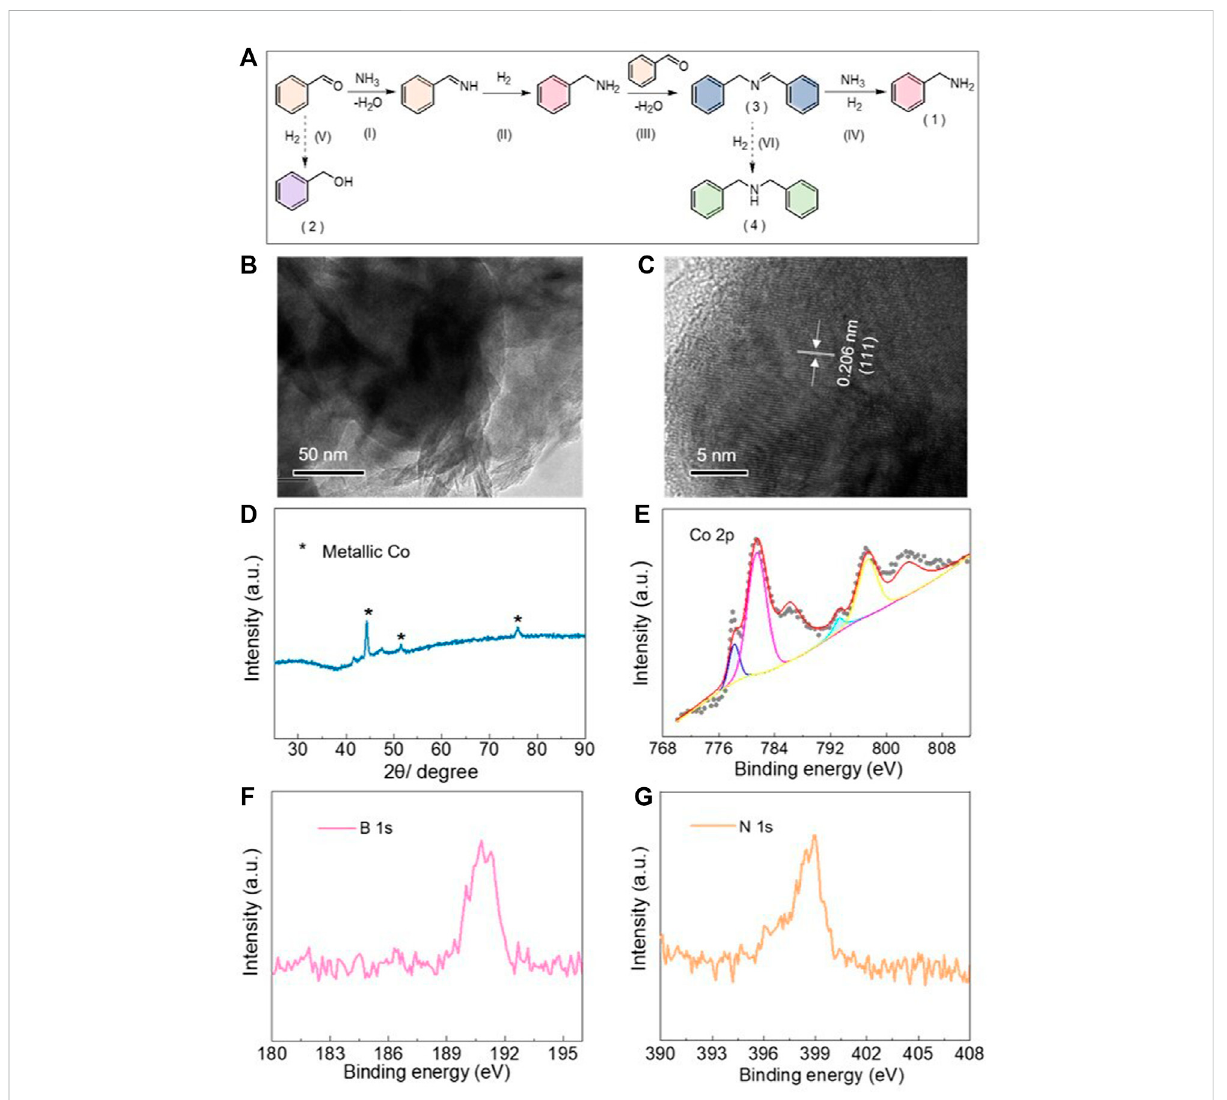
FIGURE 2 (A) Possible reaction pathway for the reductive amination between benzaldehyde and ammonia. (B) TEM and (C) HRTEM images of the reconstructed CoBO x . (D) XRD pattern and (E) XPS spectrum of Co 2p of the treated CoBO x . (F) XPS spectrum of B 1s and (G) N 1s of the treated